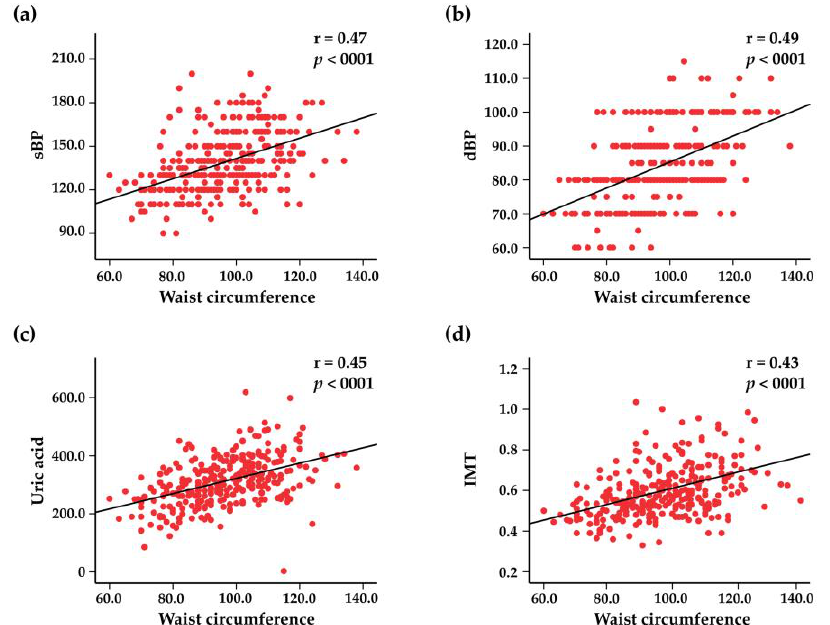
Figure 4. Scatter plots representing the correlations between waist circumference and systolic blood pressure (sBP) ( a ), diastolic blood pressure (dBP) ( b ), blood uric acid levels ( c ), and intima – media thickness (IMT) ( d ).